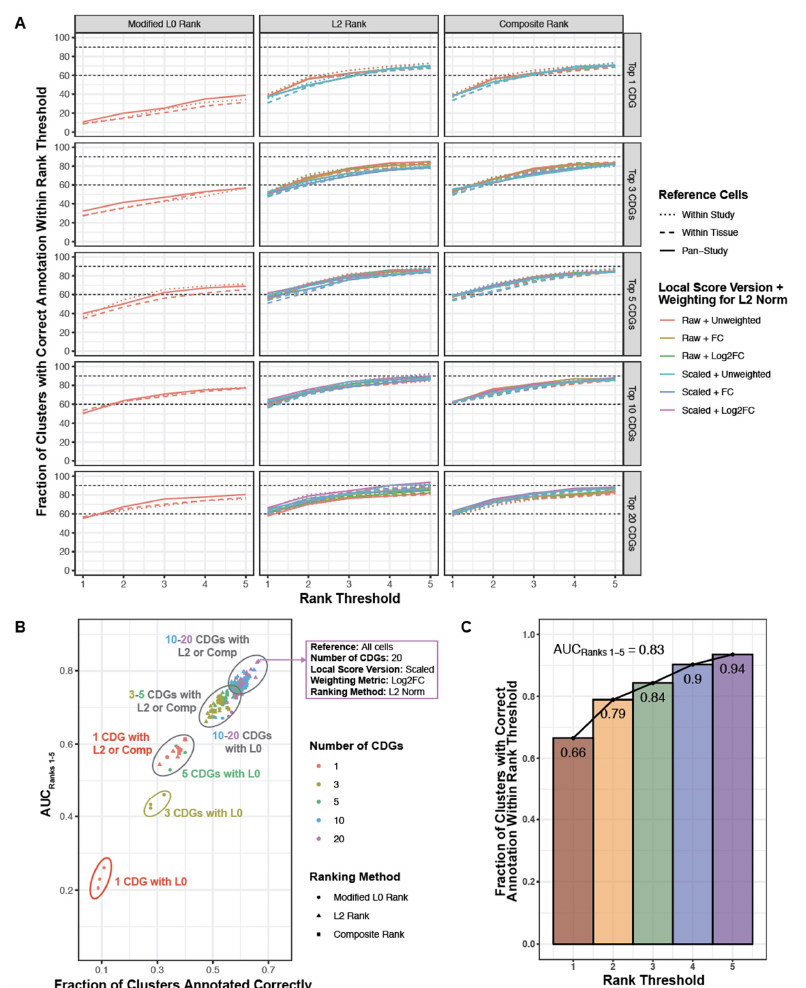
Figure 4. Performance evaluation of 195 parameter combinations for literature based augmented cell type annotation. ( A ) Each curve corresponds to one combination of parameters, where the parameters include: (1) cells used as reference to compute CDGs (encoded by line type and dot shape), (2) number of CDGs considered (encoded by the vertical facet variable), (3) the GCA version used (absolute or scaled; encoded by color), (4) the weighting method used in computing L2 norms of GCAs (also encoded by color); and (5) the metric by which candidate cell types were ranked to predict cluster identify (encoded by the horizontal facet variable). Each curve is generated from five points, specifically the percentage of clusters for which the correct annotation was present among the top 1, 2, 3, 4, or 5 predictions. ( B ) Performance summary of all 195 tested parameter combinations, considering the fraction of clusters which were annotated correctly (i.e., the top-ranked prediction which corresponded to the true cluster label) versus the AUC Ranks 1–5 metric. The metrics are highly, although not perfectly, correlated. The parameter combination which showed the highest fraction of correct annotations and the highest AUC Ranks 1–5 was taken as the optimal approach; these optimized parameters are shown in the purple inset. ( C ) Summary of algorithm performance with the optimized parameters as described in ( B ). The plot illustrates the fraction of clusters which were annotated correctly within the top 1, 2, 3, 4, or 5 ranks. The AUC Ranks 1–5 metric was estimated as the average of these five